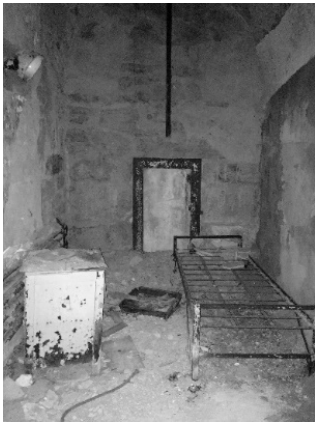
Figure 4. A view of the visitation cell at the Ulucanlar Museum.